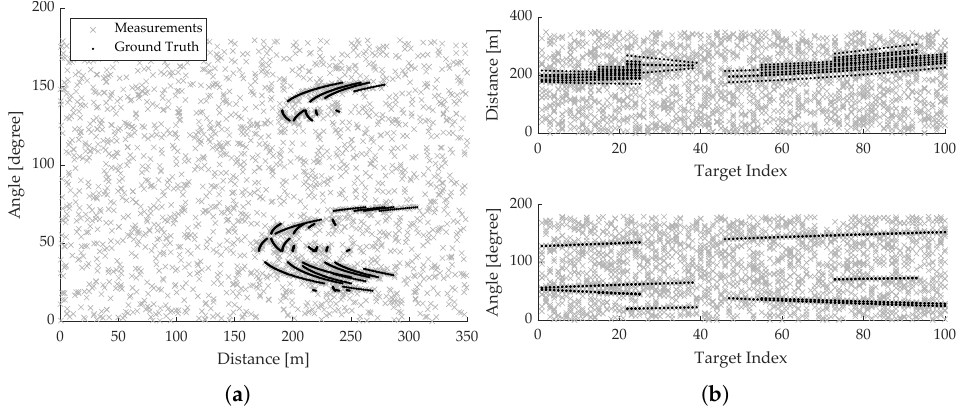
Figure 6. Ground truth and measurements with clutter: ( a ) target trajectory in the measurement space; ( b ) measurements versus target